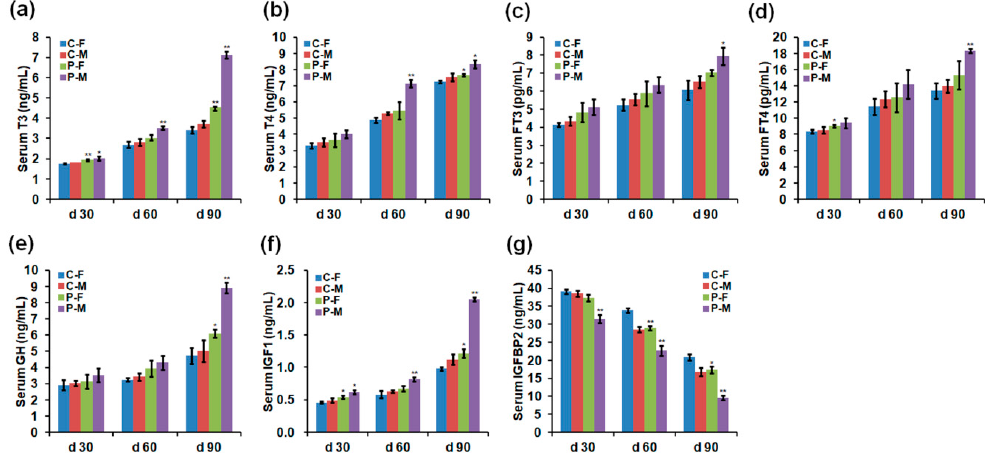
thyroxine (T4), ( c ) free triiodothyronine (FT3), ( d ) free thyroxine (FT4), ( e ) growth hormone (GH), ( f